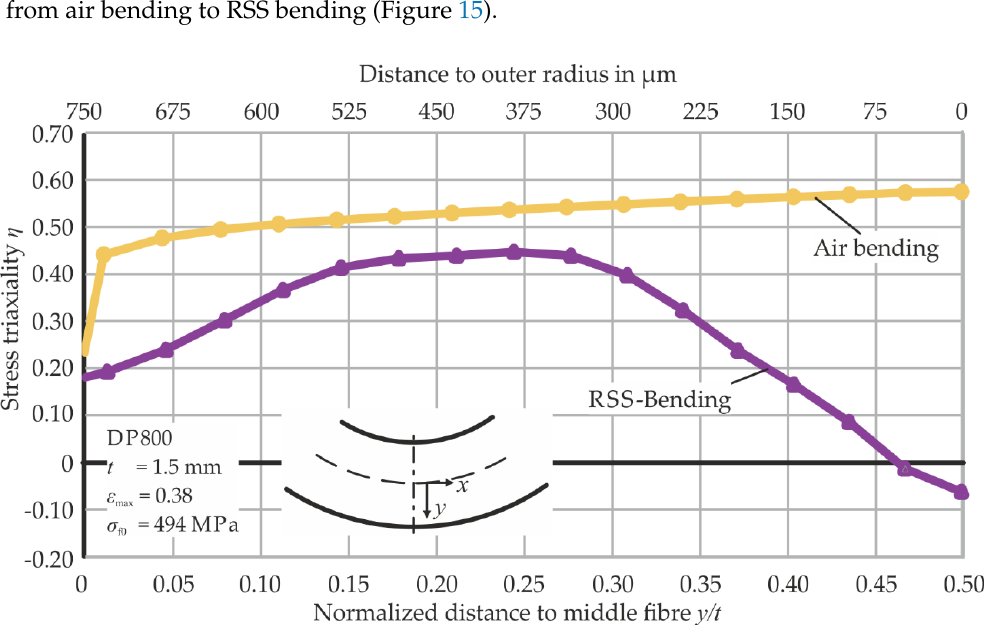
Figure 14. Equivalent strain distribution in air bending and RSS bending at the outer fiber.